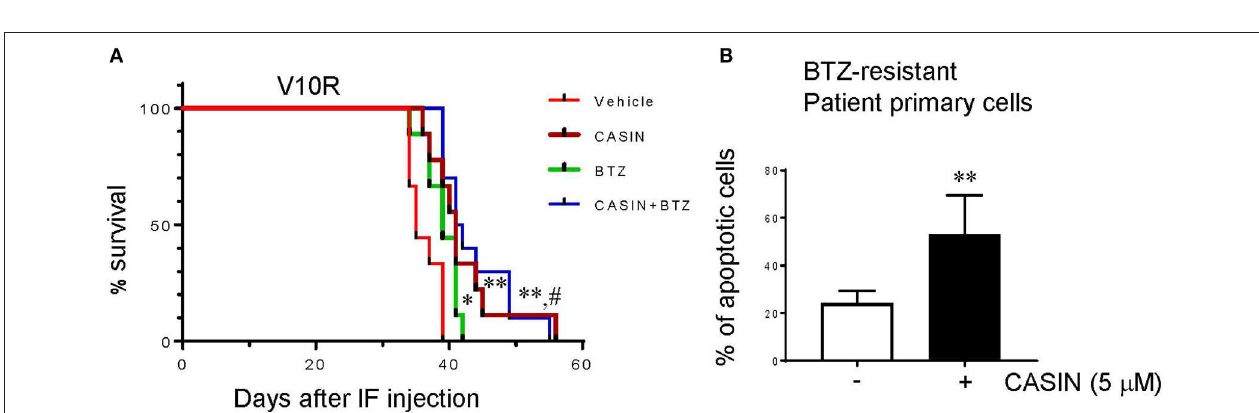
FIGURE 4 | indicated time. Cell proliferation was then measured. ** P < 0.01 (comparisons were made for 48 and 72h). (B) CASIN preferentially causes cell apoptosis in bortezomib-resistant MM cells. WT and V10R cells were treated with or without CASIN (5 µ M), BTZ (10nM), or both for 2 days. Cell apoptosis was determined using flow cytometry analysis of Annexin V + cells. ** P < 0.01. (C–J) Mechanism of action of CASIN in bortezomib-resistant MM cells. (C) Cdc42 activity is increased in bortezomib-resistant MM cells. Cdc42 activity in WT and V10R cells was measured using pull-down assay. β -Actin was used as loading control. Vertical lines indicate the gel lanes being switched in position from the original blots. (D) CASIN has no effect on AKT activity in bortezomib-resistant MM cells. WT and V10R cells were treated with or without CASIN (5 µ M) for 8h. p-AKT and total AKT were detected using western blot analysis. β -Actin was used as loading control. (E–G) CASIN suppresses epidermal growth factor receptor (EGFR), signal transducer and activator of transcription 3 (STAT3), and extracellular signal-regulated kinase (ERK) activities in bortezomib-resistant MM cells. WT and V10R cells were treated with or without CASIN for 8h. p-EGFR and total EGFR (E) , STAT3 (F) , and ERK1/2 (G) were detected using western blot analysis. β -Actin was used as loading control. (H) Inhibition of ERK mimics CASIN in inducing cell apoptosis. V10R cells were treated with or without CASIN (5 µ M) or ERK inhibitor BVD532 (BVD, 10 or 20 µ M) for 2 days. Cell apoptosis was determined using flow cytometry of Annexin V + cells. ** P < 0.01 vs. Vehicle. (I,J) Restoration of ERK activity in bortezomib-resistant MM cells partially rescues apoptosis of bortezomib-resistant MM cells. V10R cells were transduced with adenoviral mitogen-activated protein kinase 1 (MEK1) or Mock. The cells were then treated with CASIN or vehicle for 8h. p-ERK1/2, total ERK2, and MEK1 were detected using western blot analysis ( I —left). β -actin was used as loading control ( I —left). The ratio of p-ERK1/2 vs. total ERK2 was quantified ( I —right). For examination of cell apoptosis, cells were treated with CASIN or vehicle for 2 days and then analyzed for Annexin V + cells using flow cytometry (J) . ** P < 0.01. Error bars represent means ± SD of triplicates and data are representative of three independent experiments.